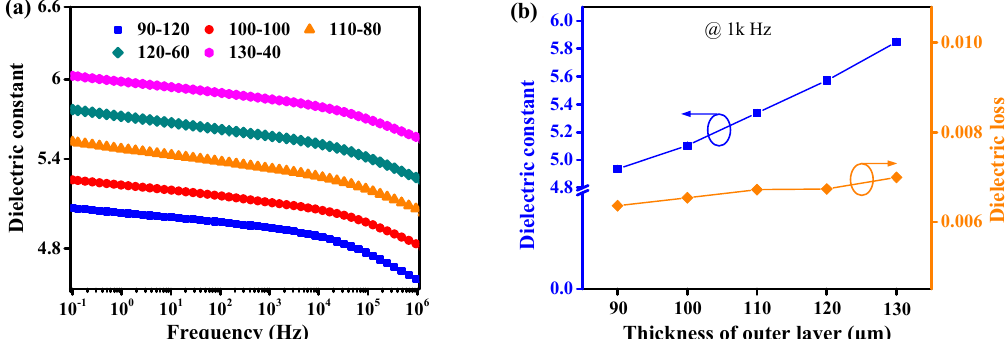
Figure 5. ( a ) dependence of frequency on dielectric constant of sandwich composites, ( b ) dependence of thickness in outer layers on dielectric loss of sandwich composites.